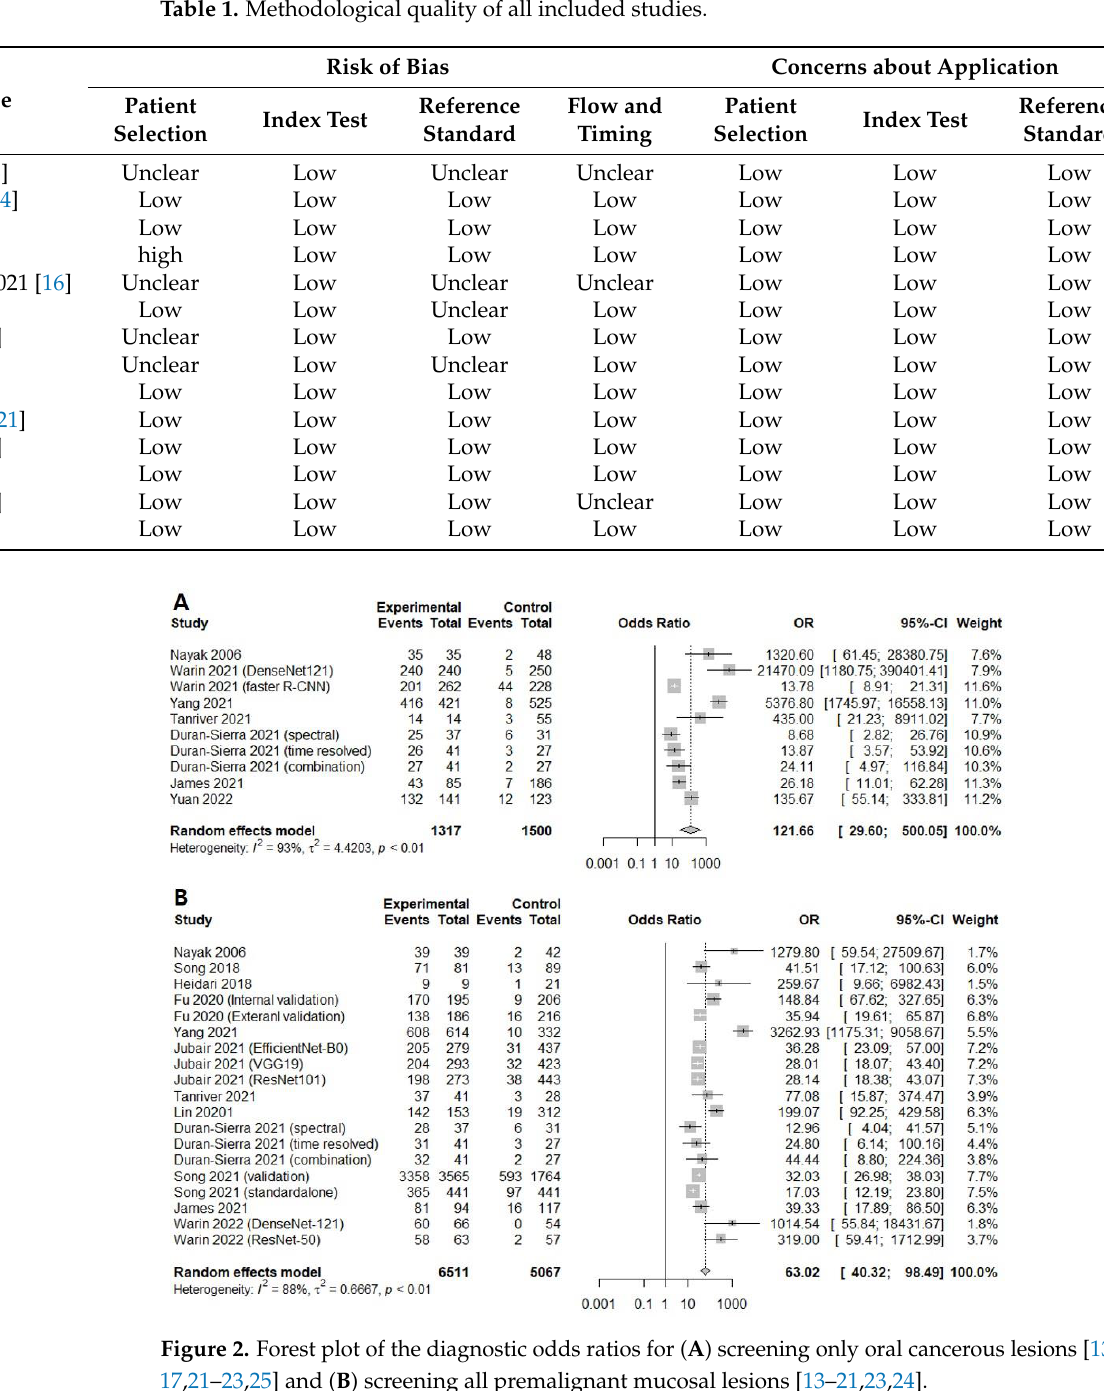
Figure 3. Area under the summary receiver operating characteristic for ( A ) screening only the oral cancerous lesions and ( B ) screening all premalignant mucosal lesions. SROC; summary receiver op- erating characteristic, CI; confidence interval. The correlation between the sensitivity and the false-positive rate was 0.437, indicat- ing the absence of heterogeneity. AI-assisted screening exhibited good sensitivity (0.9232 [0.8686; 0.9562]; I 2 = 81.9%), specificity (0.9494 [0.7850; 0.9897], I 2 = 98.3%), and negative